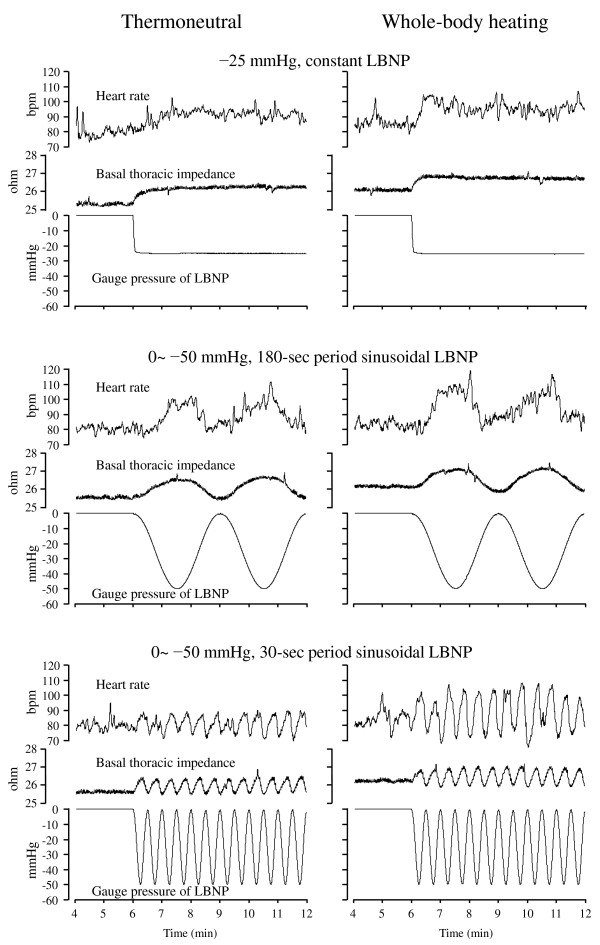
Traces of heart rate (HR), basal thoracic impedance (Z0), and gauge pressure of LBNP from three conditions of LBNP (−25 mmHg constant LBNP, 30-s and 180-s period of sinusoidal LBNP) during thermoneutral and whole-body heating conditions in the same male subject. The average value of LBNP (CLC) was configured with −25 mmHg in all conditions.